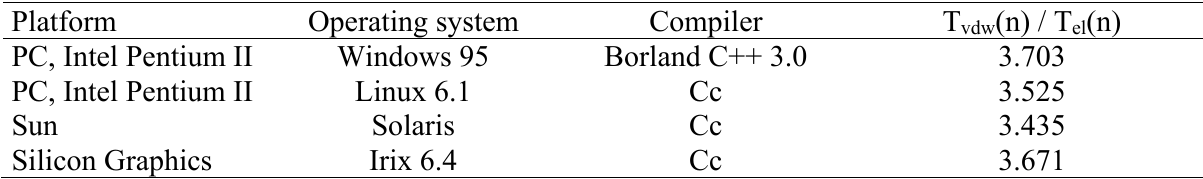
energies calculation.